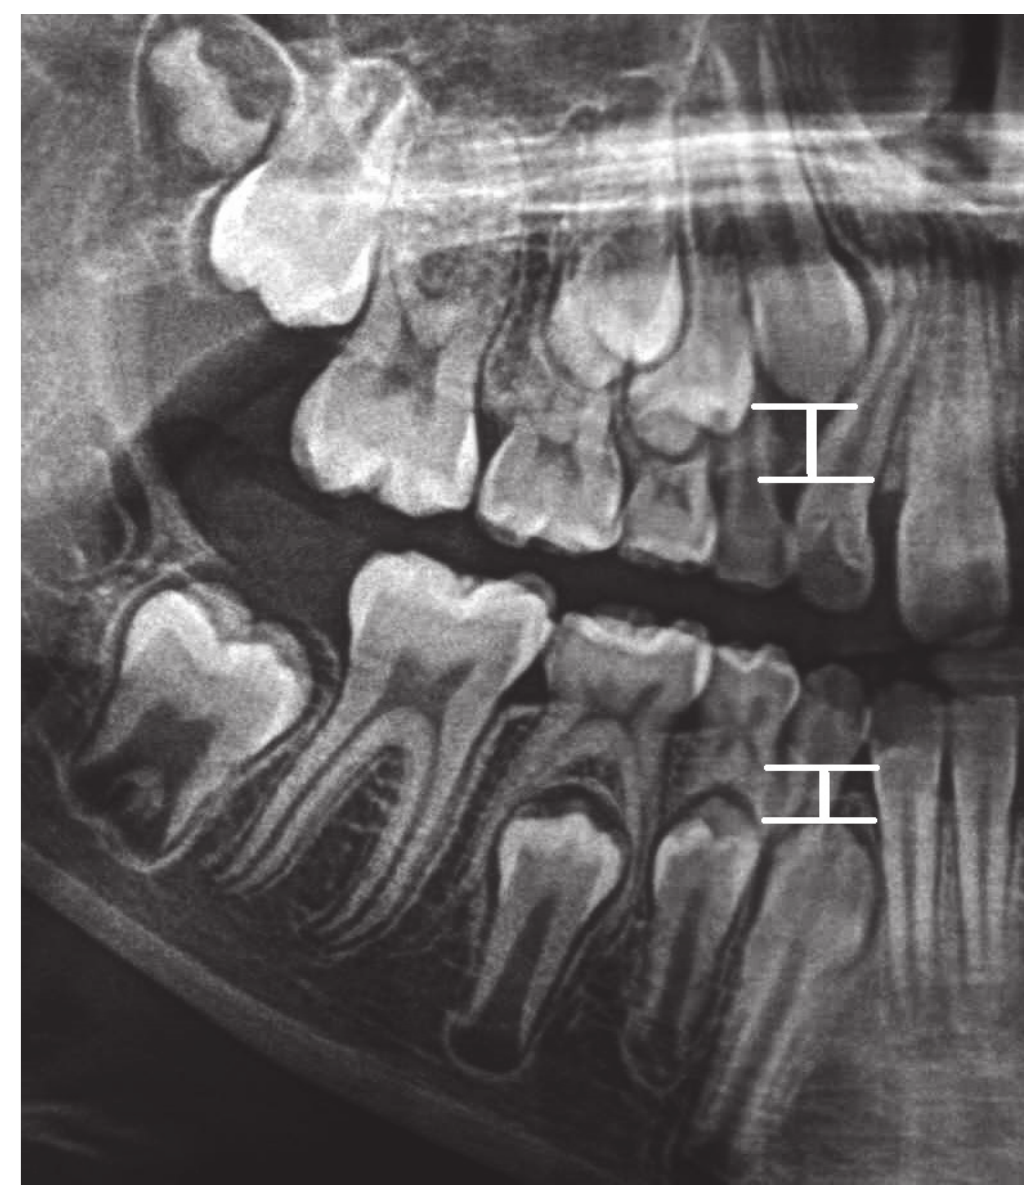
Figure 4. Graphic representation of the S13-W13 and S 43-W43 distances. S14-W14 is the distance between point S14 (on the incisal margin of tooth 14) from point W14 (the point on the alveolar margin in the line drawn through the point on top of the alveolus perpendicular to the X line).